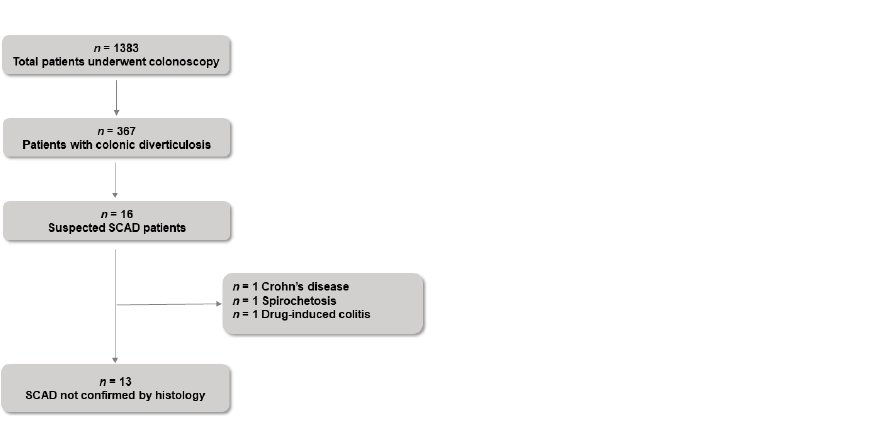
Figure 2. A flowchart of the study population. SCAD: segmental colitis associated with